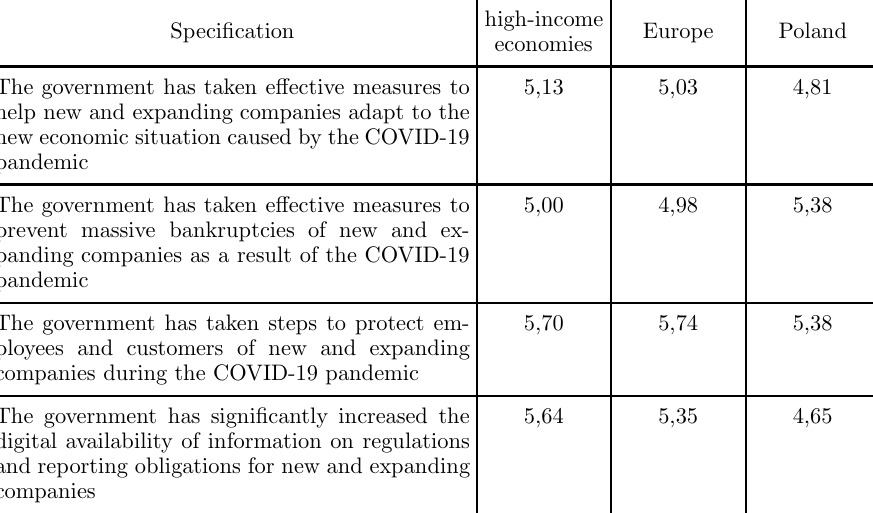
Assessing the determinants of entrepreneurship development in Poland – the impact of COVID-19 on government policy. Poland compared to high-income economies and European countries in 2020 high-income Specification Europe Poland